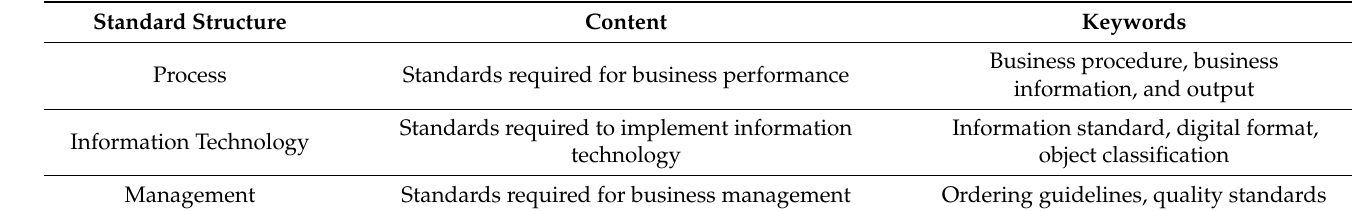
Table 4. Standard structure of a BIM roadmap.